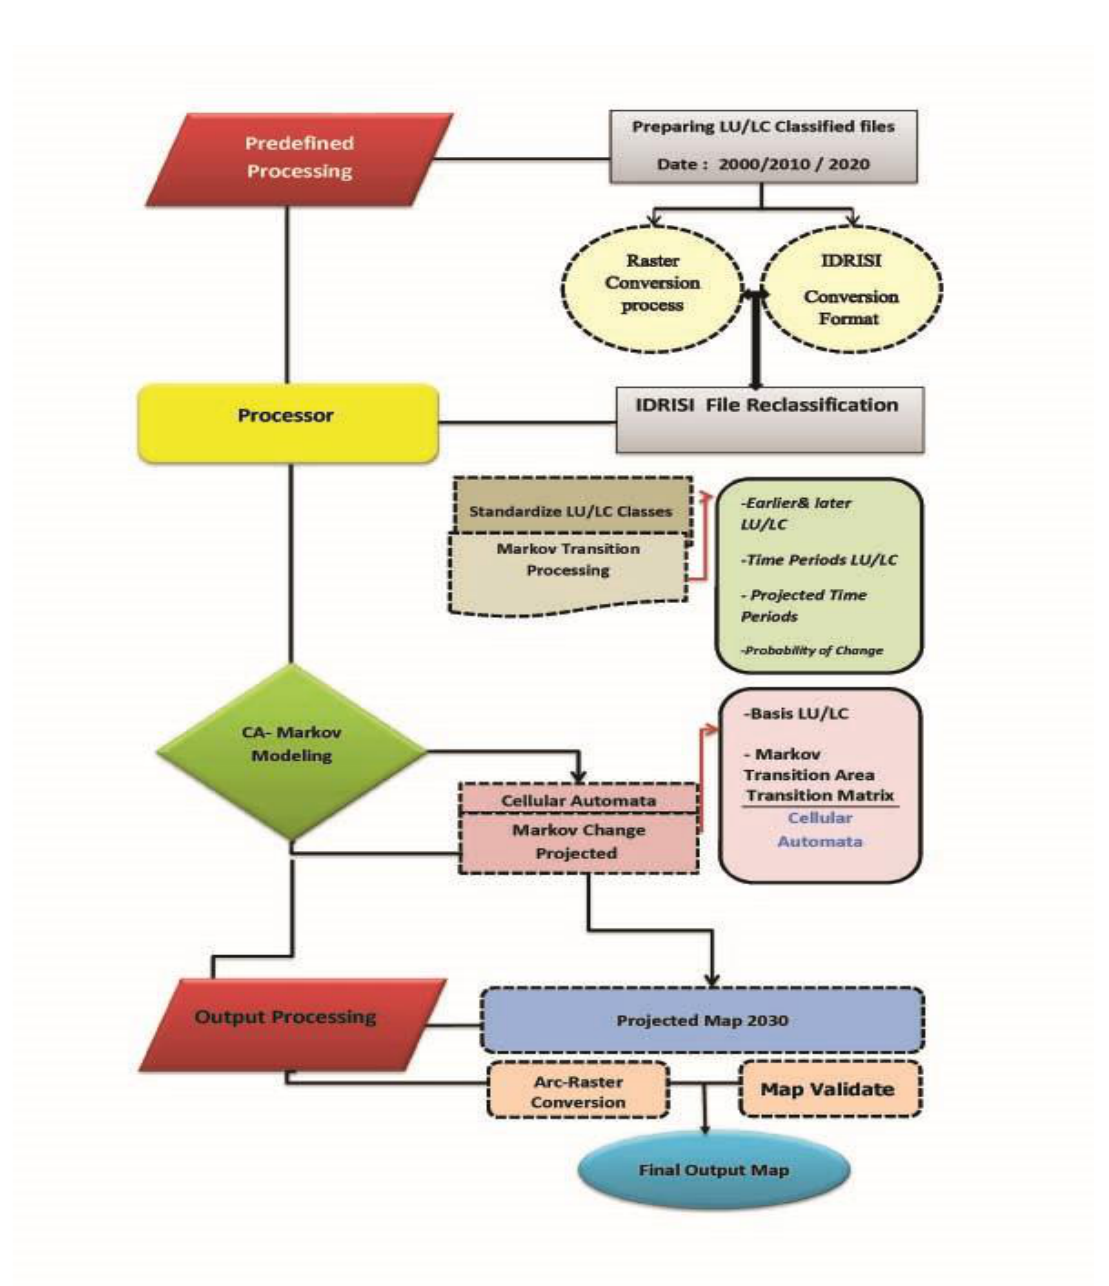
Figure 2. Workflow of clarifying steps of study methodology